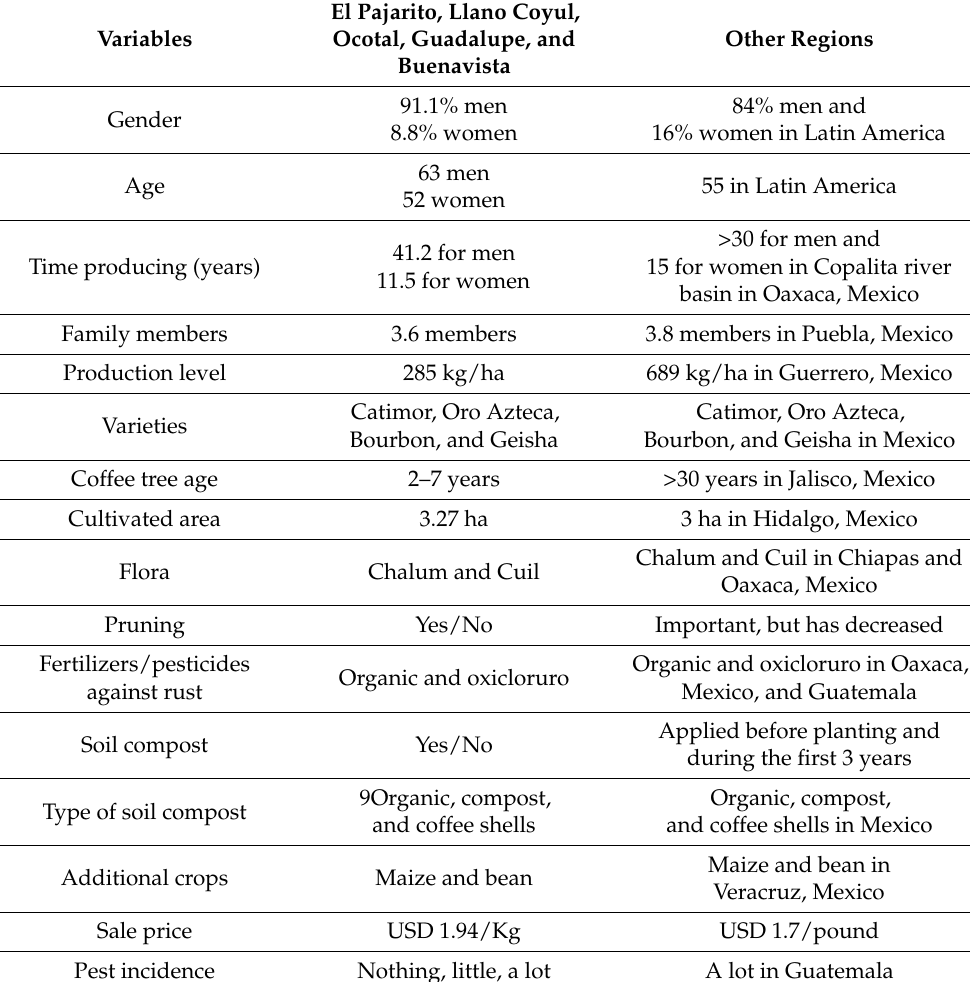
Table 8. Discussion of social and productive